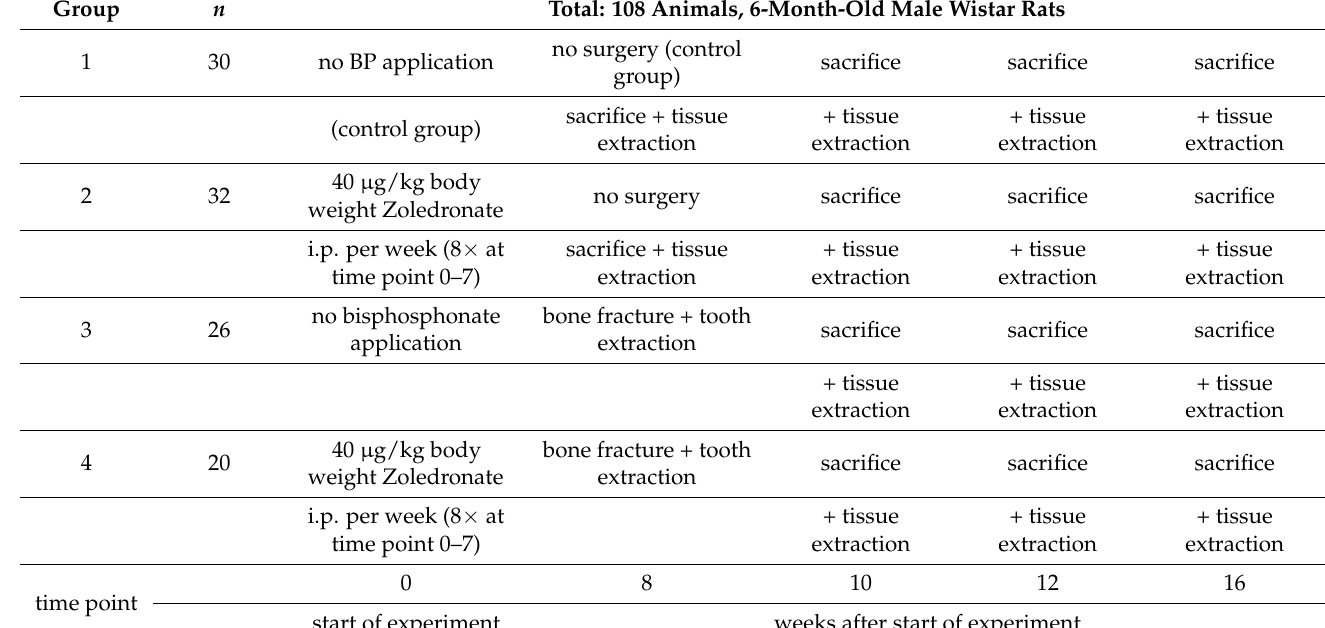
Table 4. Overview of the time schedule for animal treatment and tissue extraction.